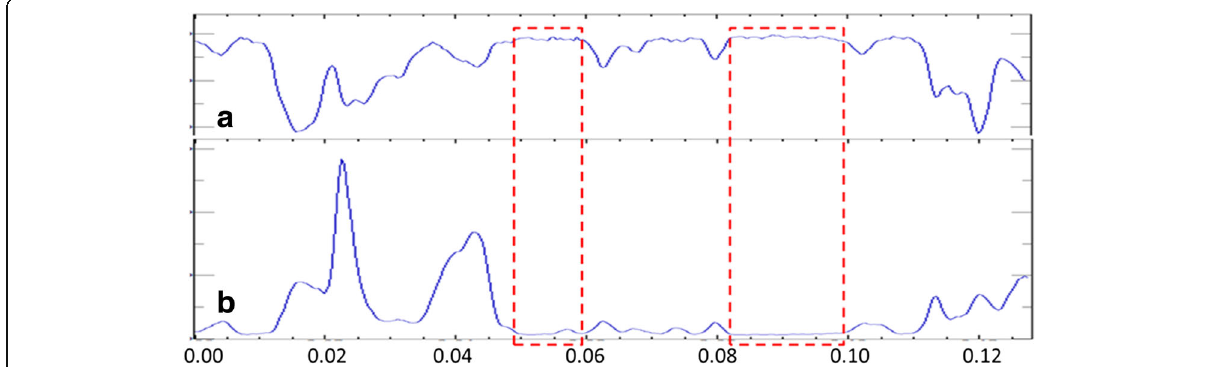
Fig. 5 Element distribution line scanning of sintered nanocomposites with 0.2 wt% graphenes and 0.8 wt% MWCNTs. a Cu and b